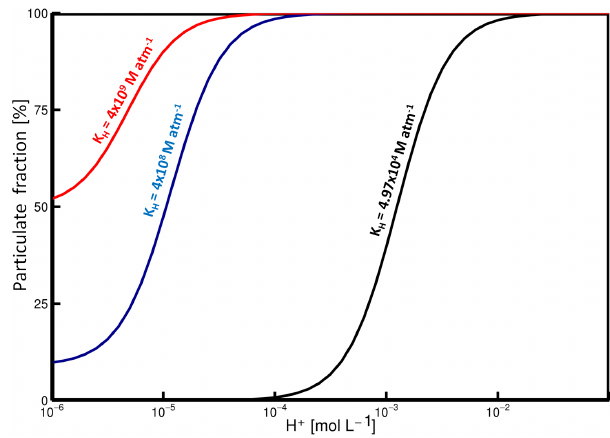
Figure 11. Evolution of the particulate fraction of a given species as a function of H + concentration according to the Eq. (1), for three different values of its Henry’s law constant K H = [ 4 . 97 × 10 4 ; 4 × 10 8 ; 4 × 10 9 Matm − 1 ] at a LWC of 10 − 11 cm 3 watercm − 3